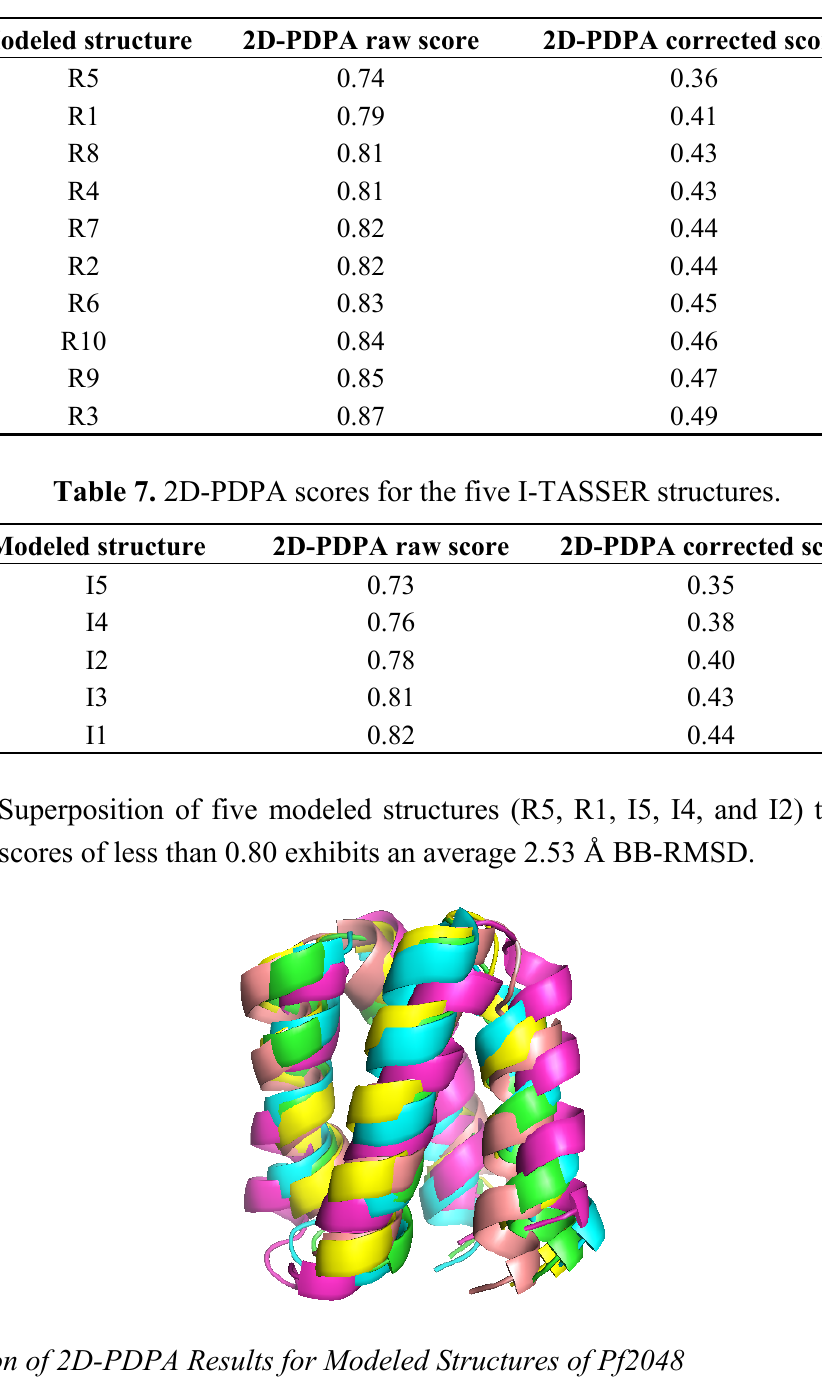
Table 6. 2D-PDPA scores for the ten ROBETTA structures.